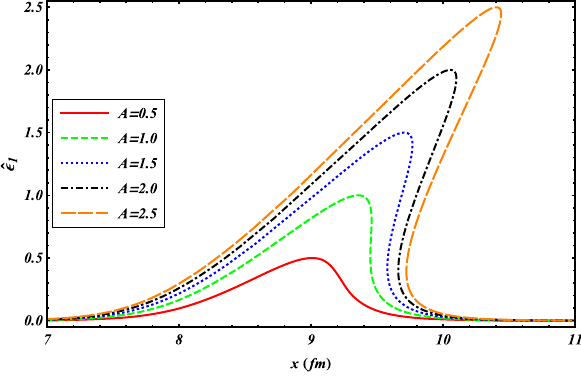
Fig. 3 Solutions at t = 15 f m for different amplitudes of the initial wave. B = 0 . 5 f m , q = 1 . 08, and T = 140